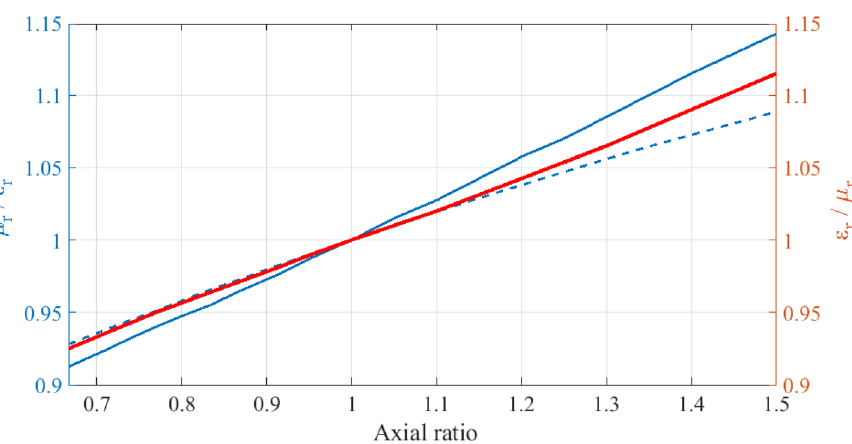
Figure 6. The permeability to permittivity(permittivity to permeability) ratio that achieves minimum backscattering for each different axial(pitch) ratio of the ellipsoid(array) is shown by the continuous blue(red) line. The blue dashed line is an analytical prediction of the axial ratio required for the